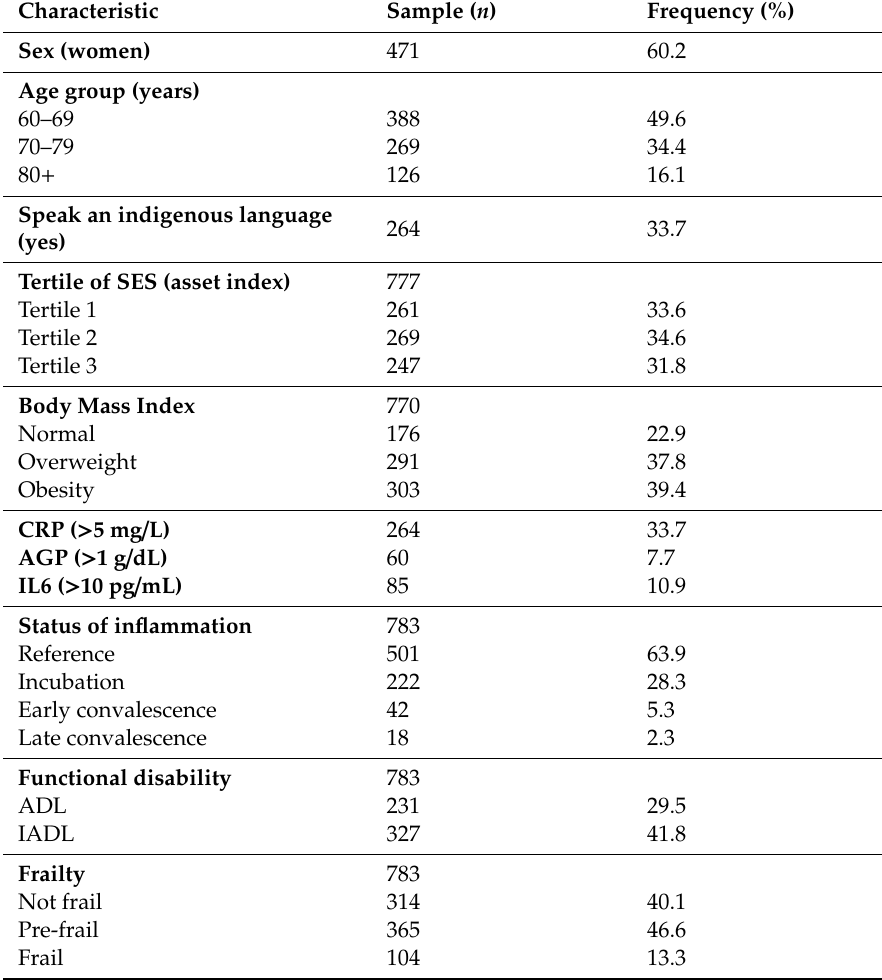
Table 1. Descriptive characteristics of older Mexican adults